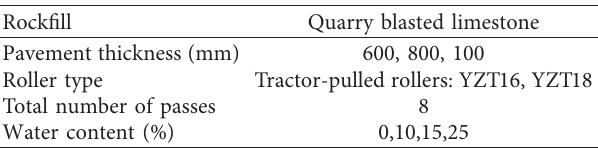
Table 2: Field experiments of the vibratory roller compaction of field rockfills in the Shui Buya Project.